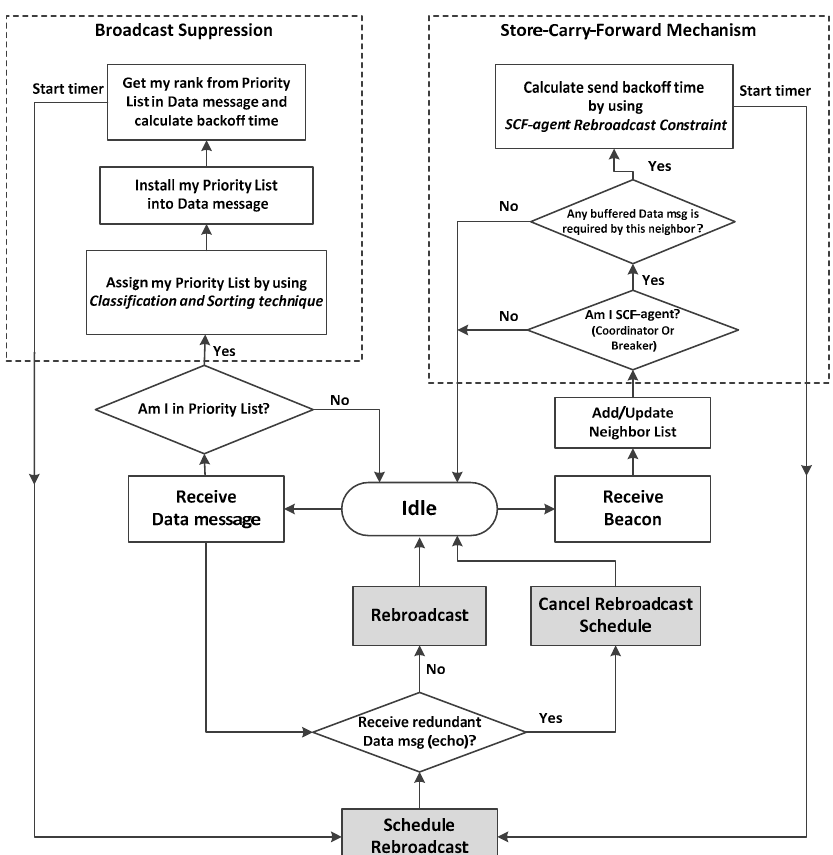
Figure 2. The operation of TrAD protocol flowchart.